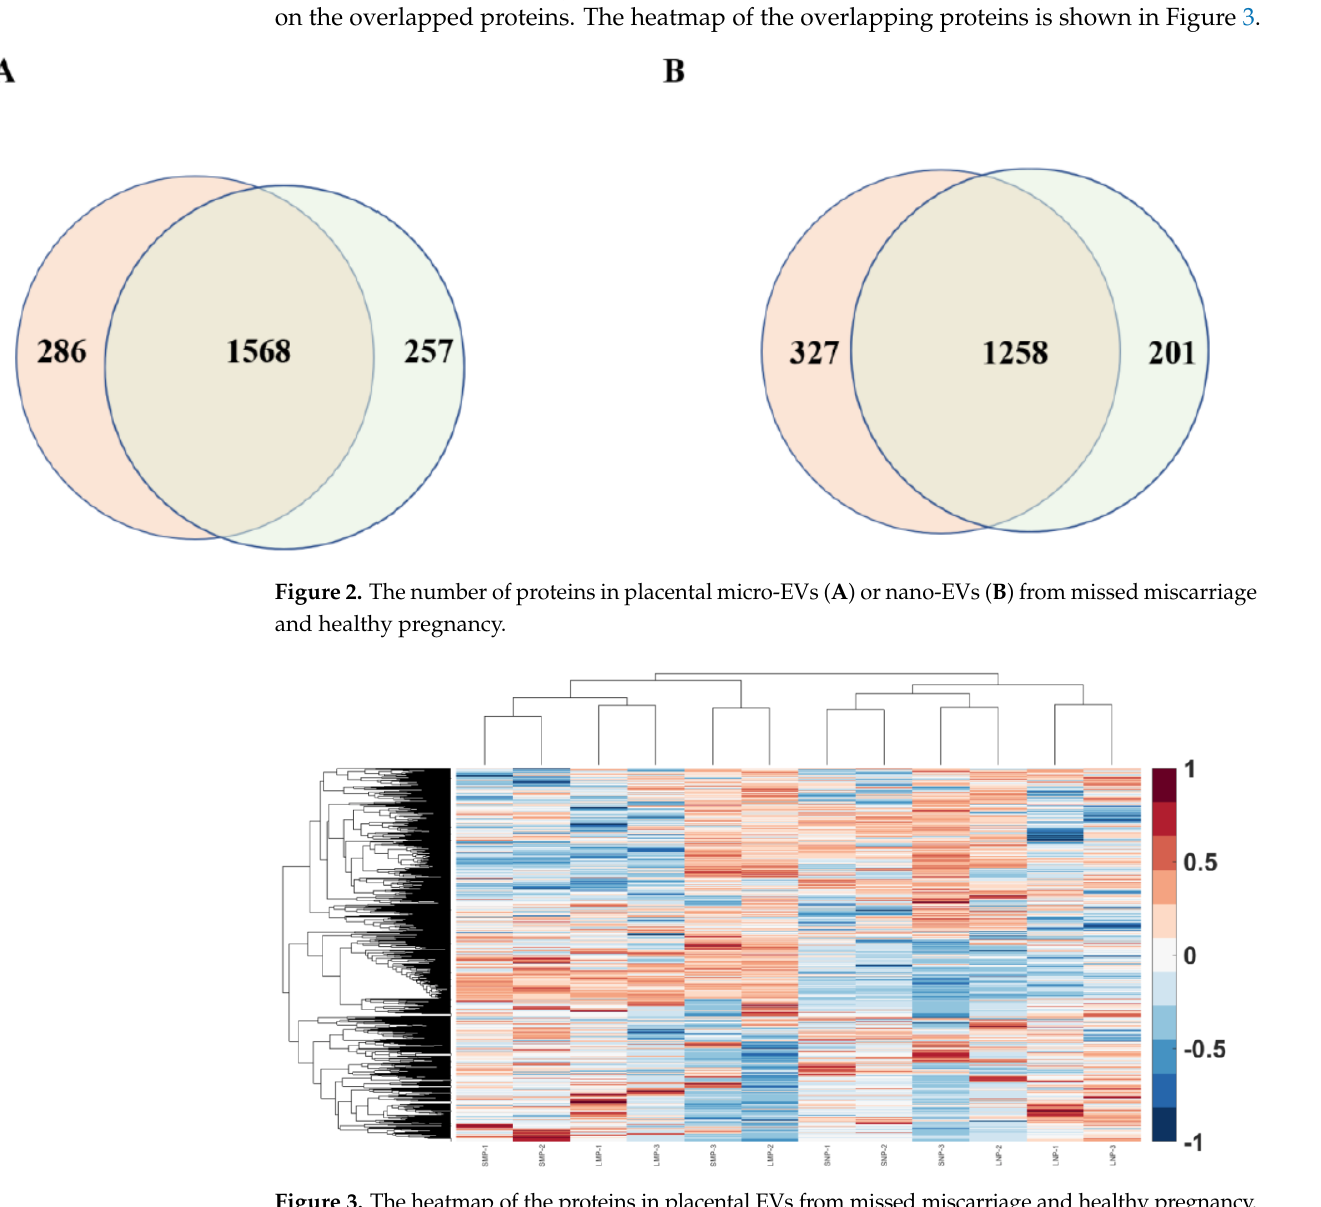
Figure 3. The heatmap of the proteins in placental EVs from missed miscarriage and healthy